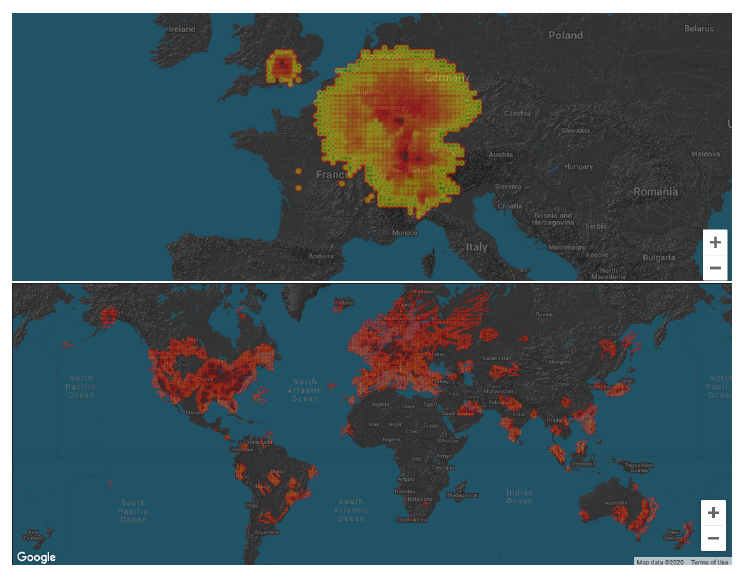
Figure 1. Coverage of OpenSky on 5 October 2014 ( top ) and 1 November 2020 ( bottom ). c (cid:13) Google